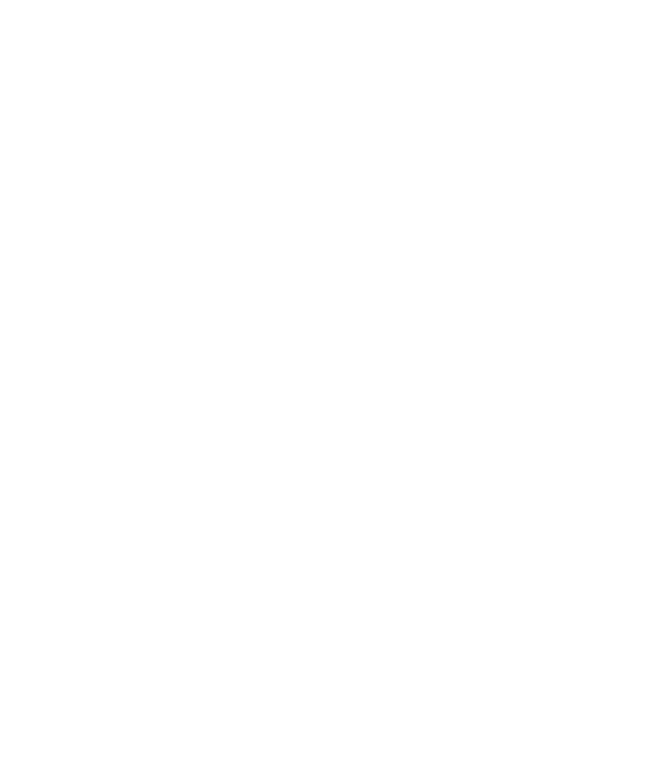
Figure 3. SDS-PAGE of VsAly7D. Lane M, protein standard marker and lane 1, purified VsAly7D.